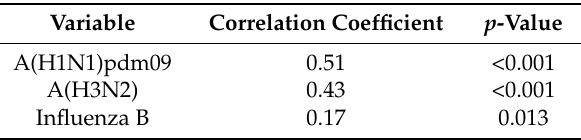
Table 3. Correlation analysis of weekly influenza virus type/subtype constitution among total positive numbers between influenza-like illness (ILI) and severe acute respiratory illness (SARI). Variable Correlation Coefficient p -Value